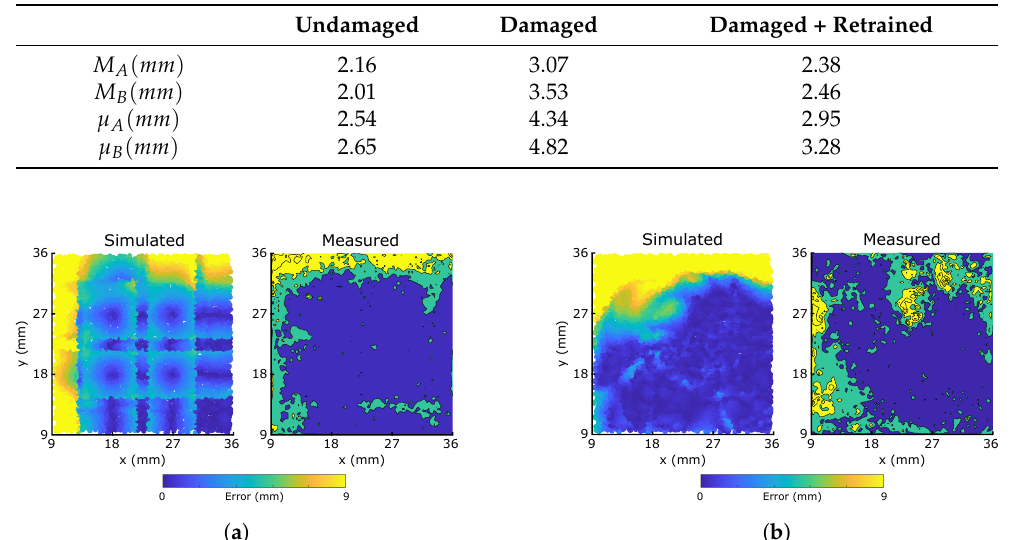
Table 1. Mean ( µ ) and median ( M ) error values for the 6 plots in Figures 8, 9 and 11.